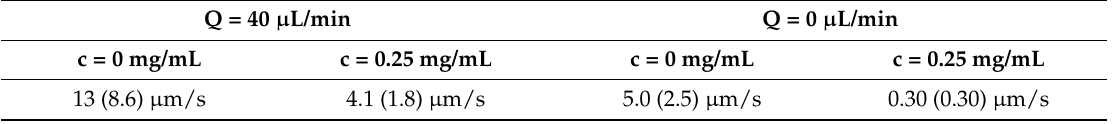
Table 3. Comparison of average growth rate of ice particles.